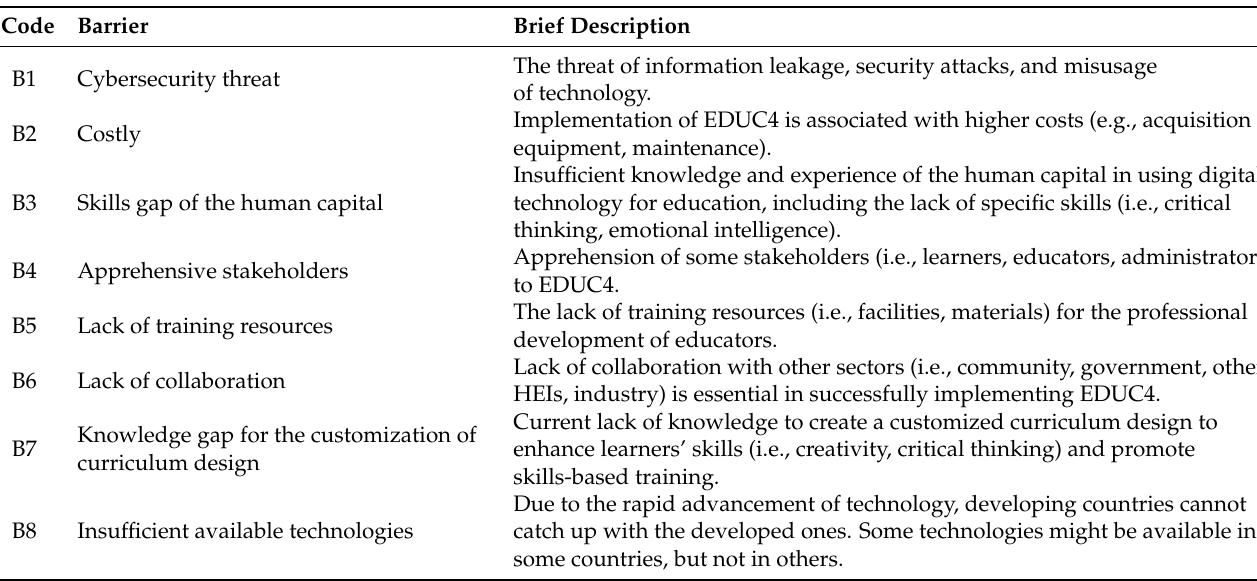
Table A1. Barriers to EDUC4 (adopted from Ref.